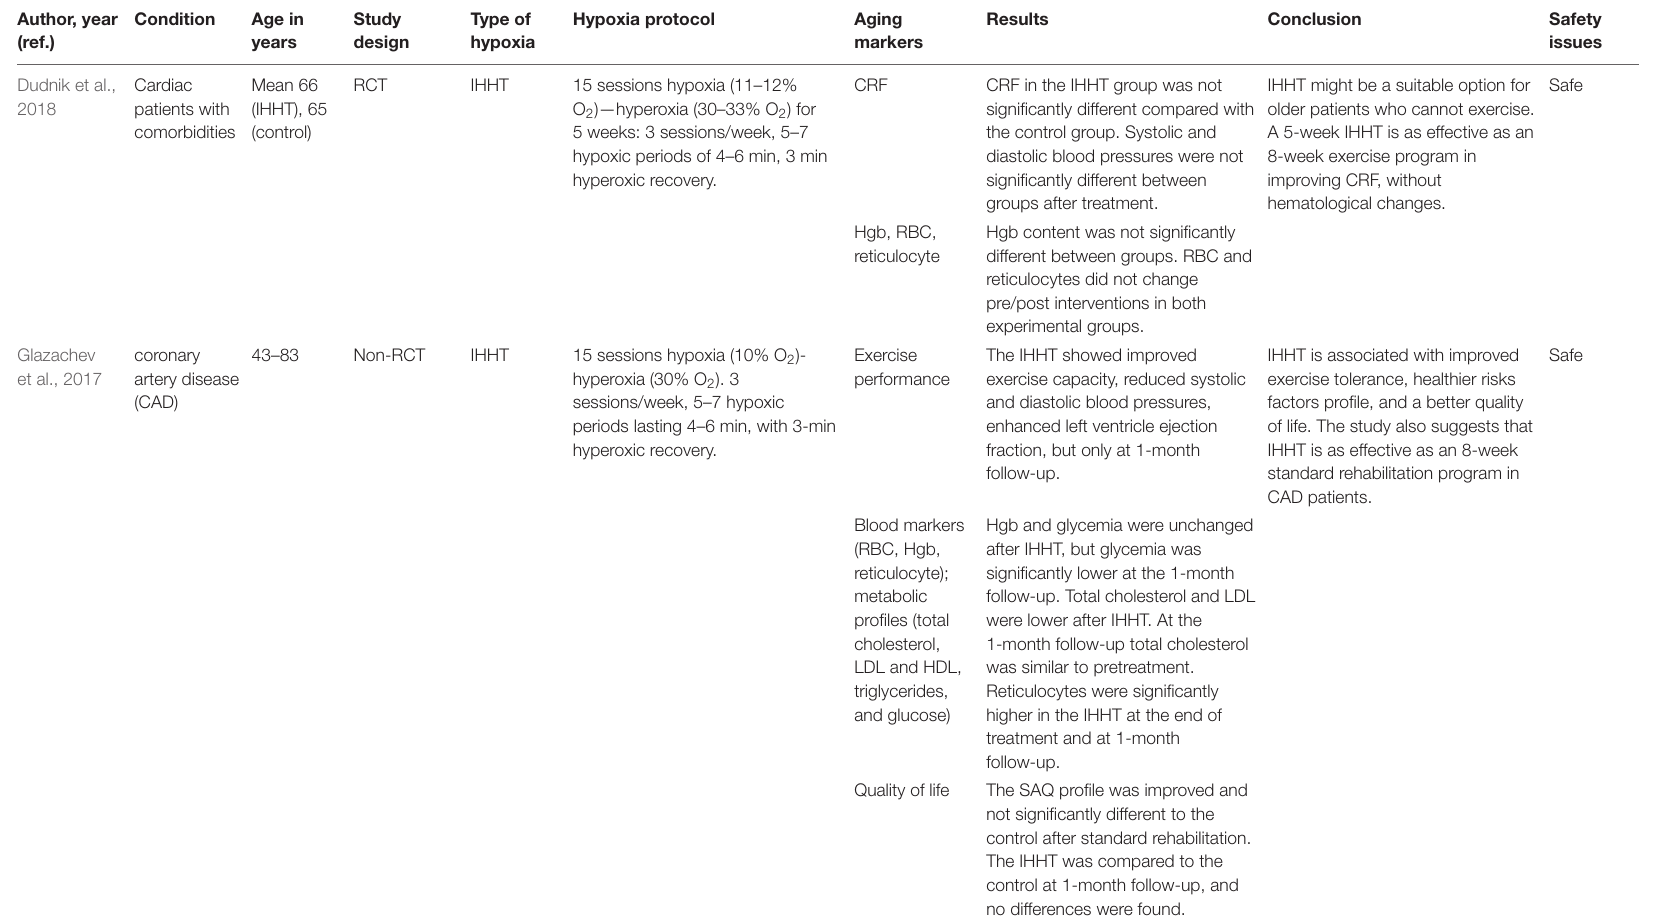
TABLE 2 | The effects of intermittent hypoxia-hyperoxia training (IHHT) on aging markers and age-related diseases. Author, year